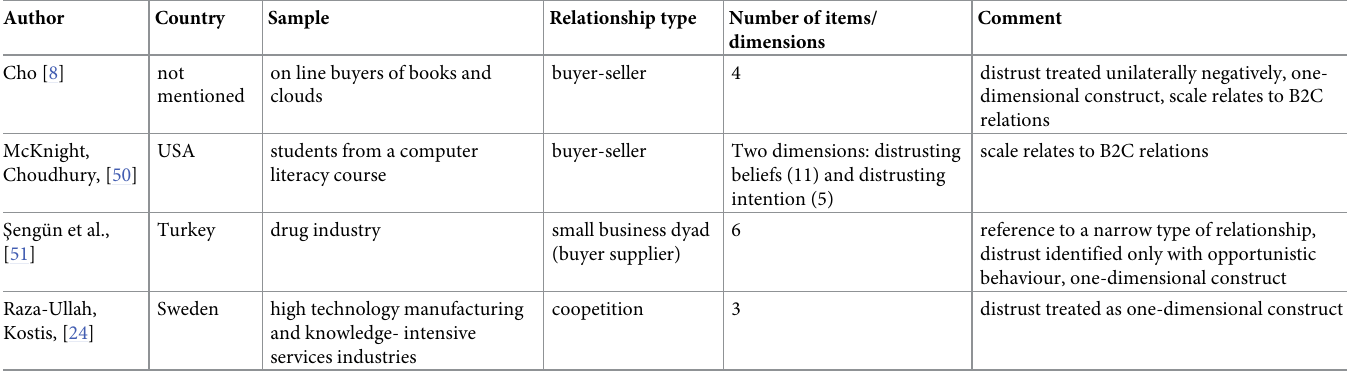
Table 1. Scales for studying distrust in